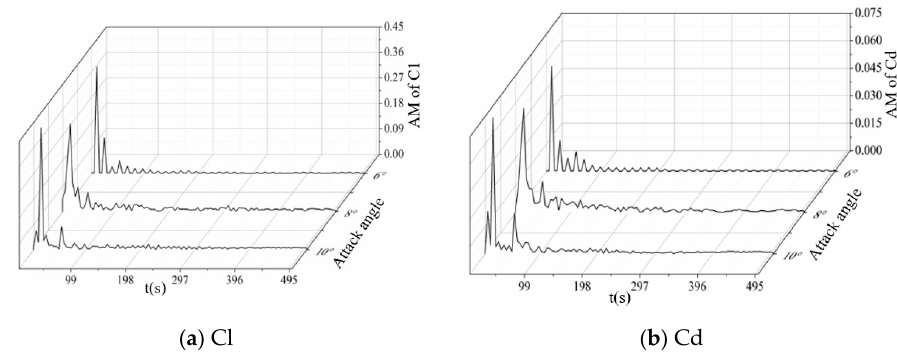
Figure 13. FFT analysis of Cl and Cd at different attack angles.